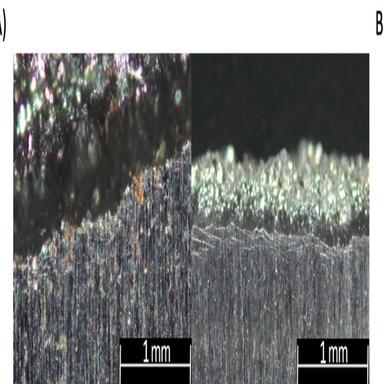
Surface Edge side view of Additive Manufactured CT Specimen Crack, A) 0◦ and B) 45◦.